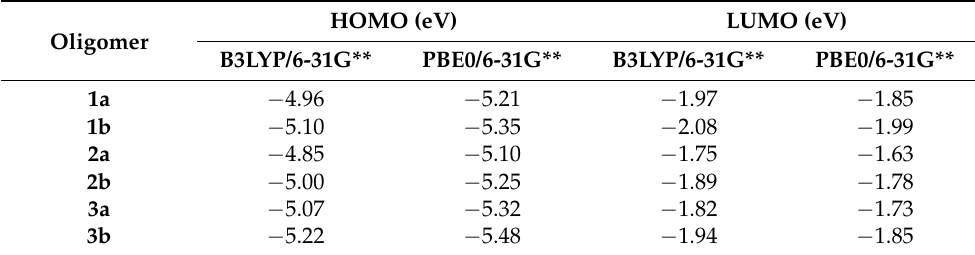
Table 2. DFT-calculated frontier orbital energies.